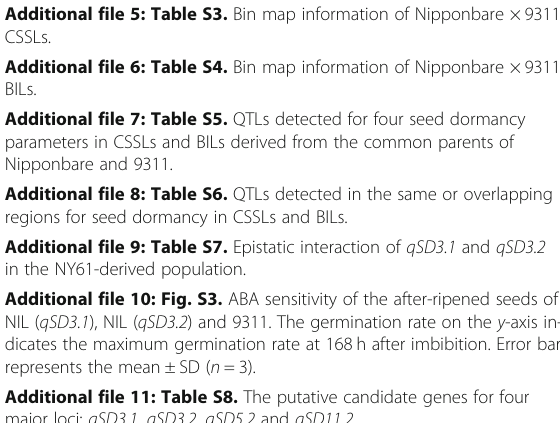
Additional file 6: Table S4. Bin map information of Nipponbare × 9311